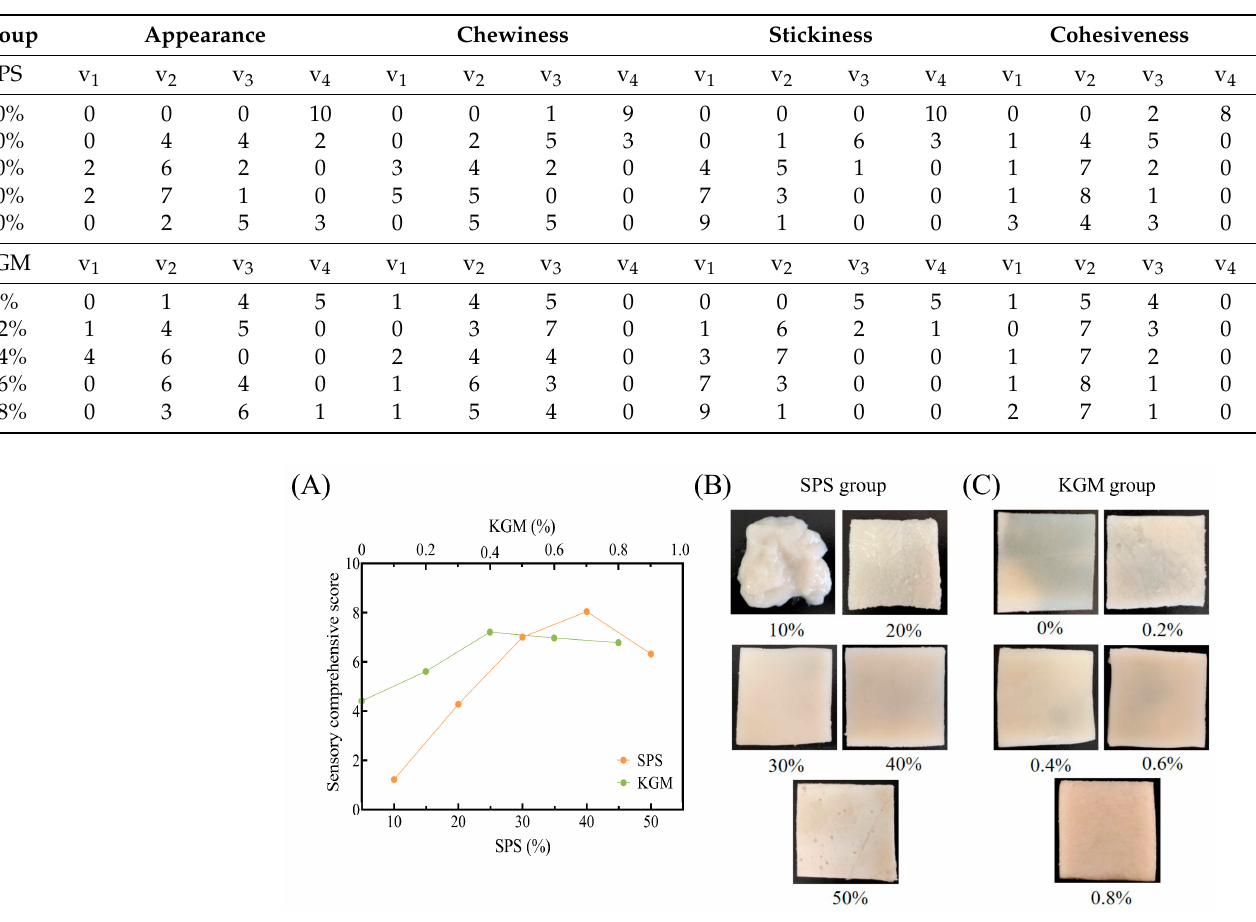
Table 2. The preliminary sensory score of the plant-based pork rinds containing different SPS and